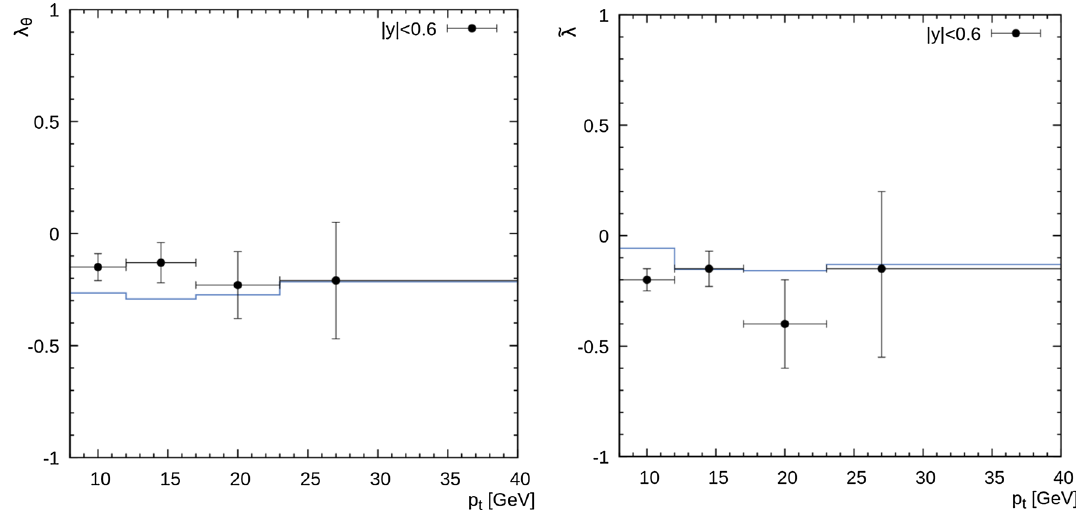
Fig. 14 The polarization parameters λ θ and ˜ λ of the ϒ( 1 S ) mesons calculated in the helicity frame as functions of its transverse momentum at √ s = 1 . 96 TeV. The notation of all histograms is the same as in Fig. 11. The experimental data are from CDF